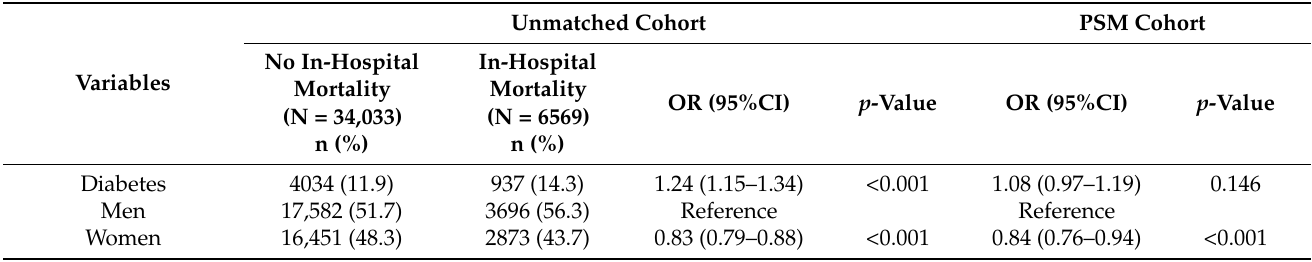
Table 3. Comparison and simple logistic regression analysis of in-hospital mortality with diabetes and other variables in unmatched and propensity score-matched